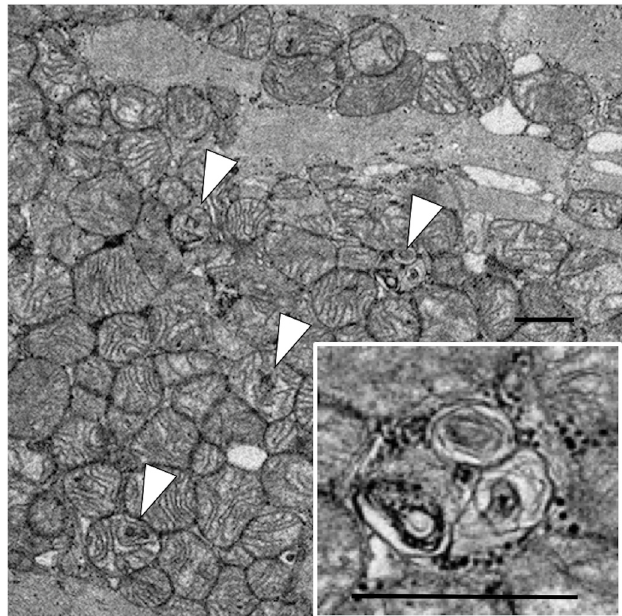
Figure 2. Electron microscopic investigation of endomyocardial biopsy. Electron microscopy revealed mitochondrial myelinizations of the cristae in cardiomyocyte. Arrows indicate cardiomyocytes with the mitochondrial injury. Scale bar: 1